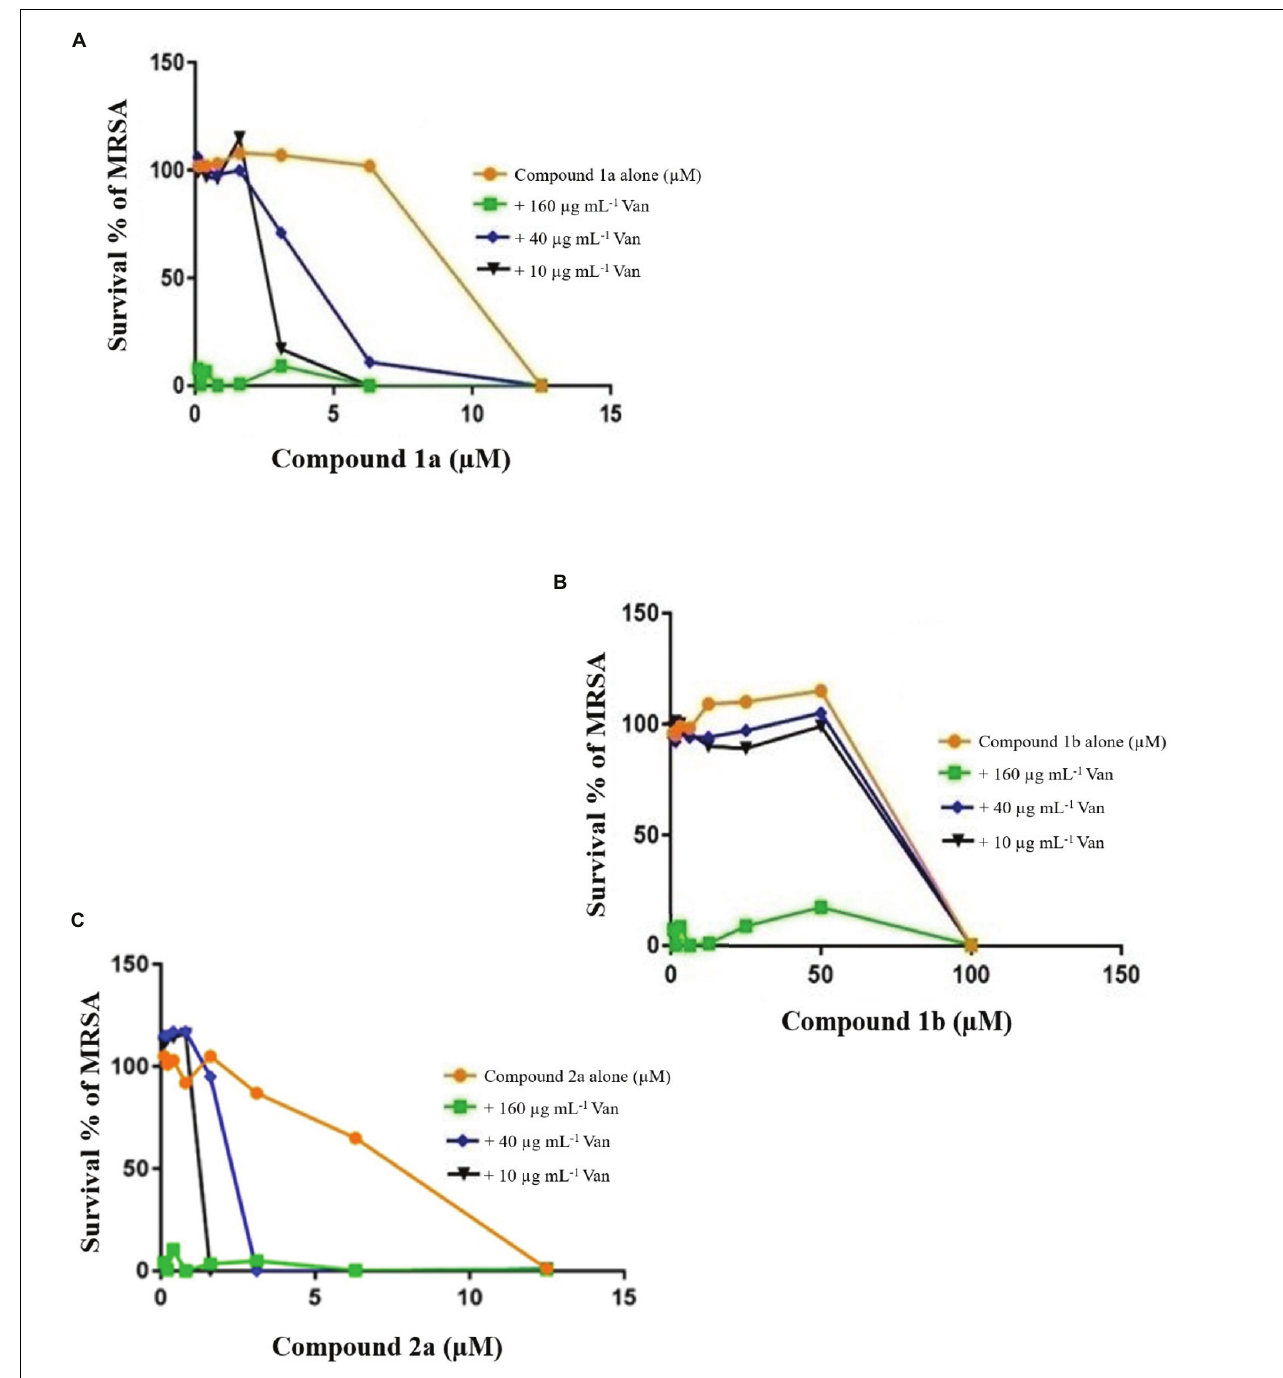
FIGURE 3 | Checkerboard study between vancomycin 1a (A) , 1b (B) , and 2a (C) . MRSA was incubated with varying concentrations of vancomycin (Van) together with dilutions of the synthetic drugs 2a (A) , 1a (B) , and 1b (C) . Graph displays the mean survival of triplicate samples and represents data from three independent